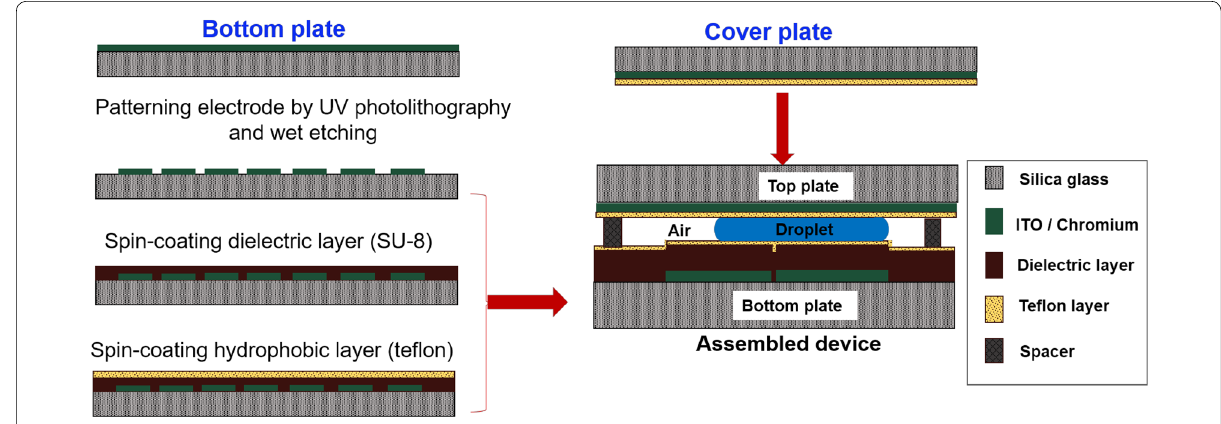
Fig. 3 Fabrication process of an EWOD DMF device (side